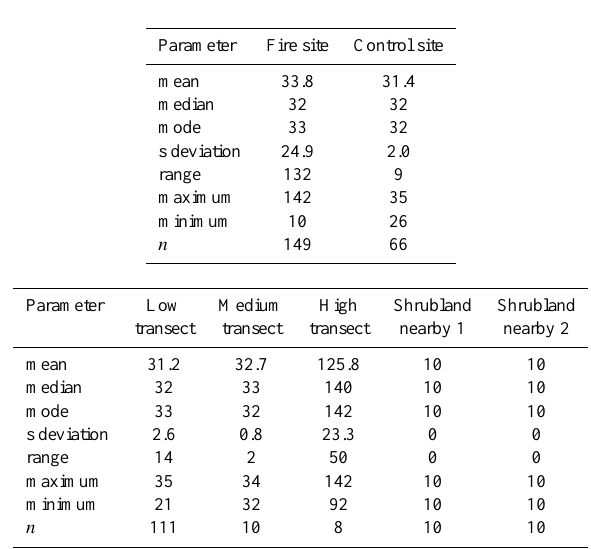
Table 1. Descriptive statistics of ages for both sampling sites and for each sampling sub-site in the “fire